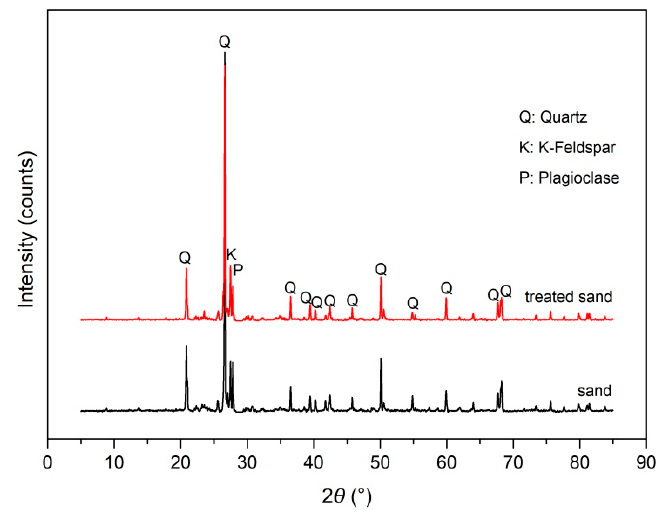
Figure 15. The XRD tests results of ( a ) sand and ( b ) polymer-treated sand.